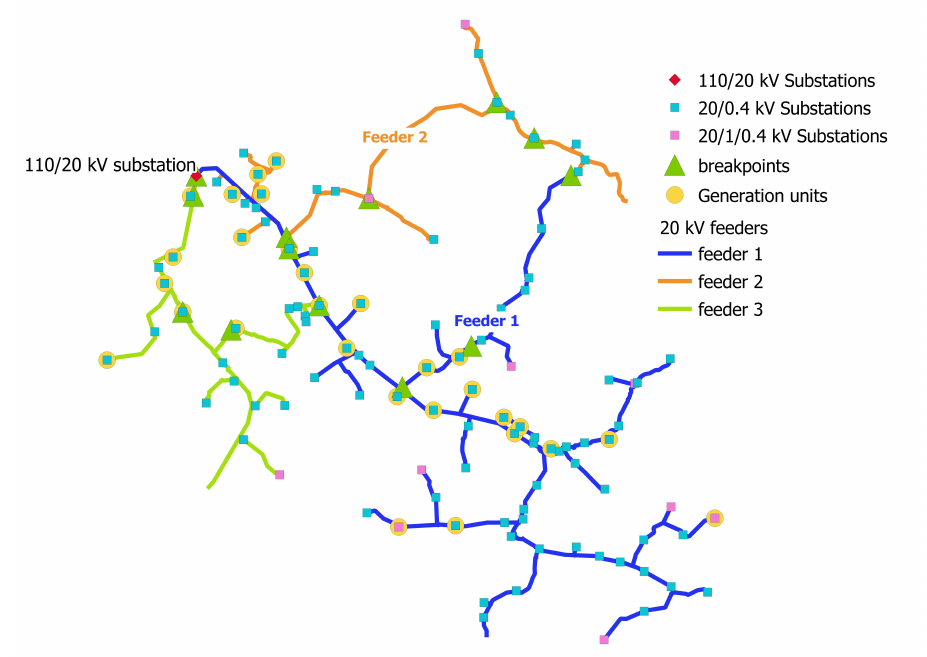
Figure 4. Single-line diagram of a test MV DN.